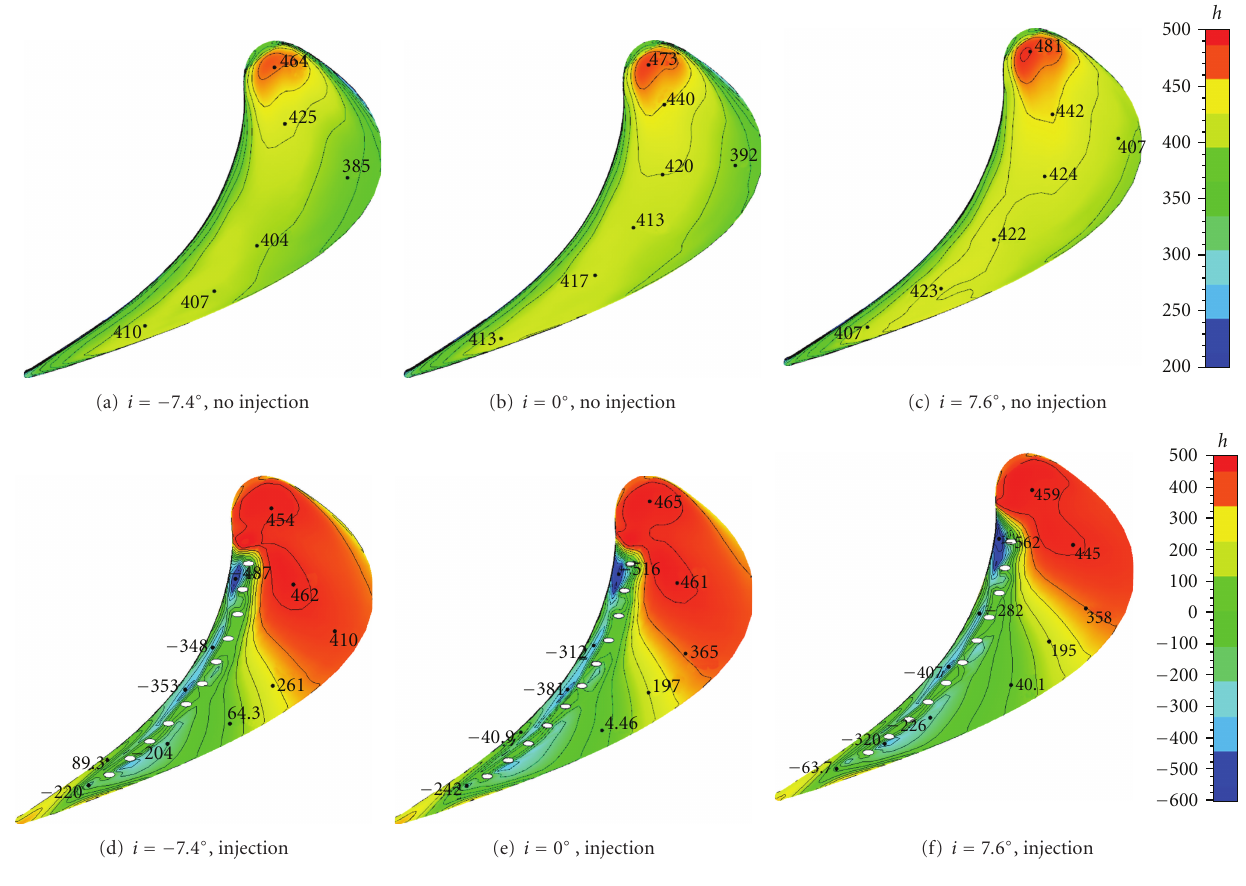
Figure 7: Distribution of heat transfer coe ffi cient on the blade tip